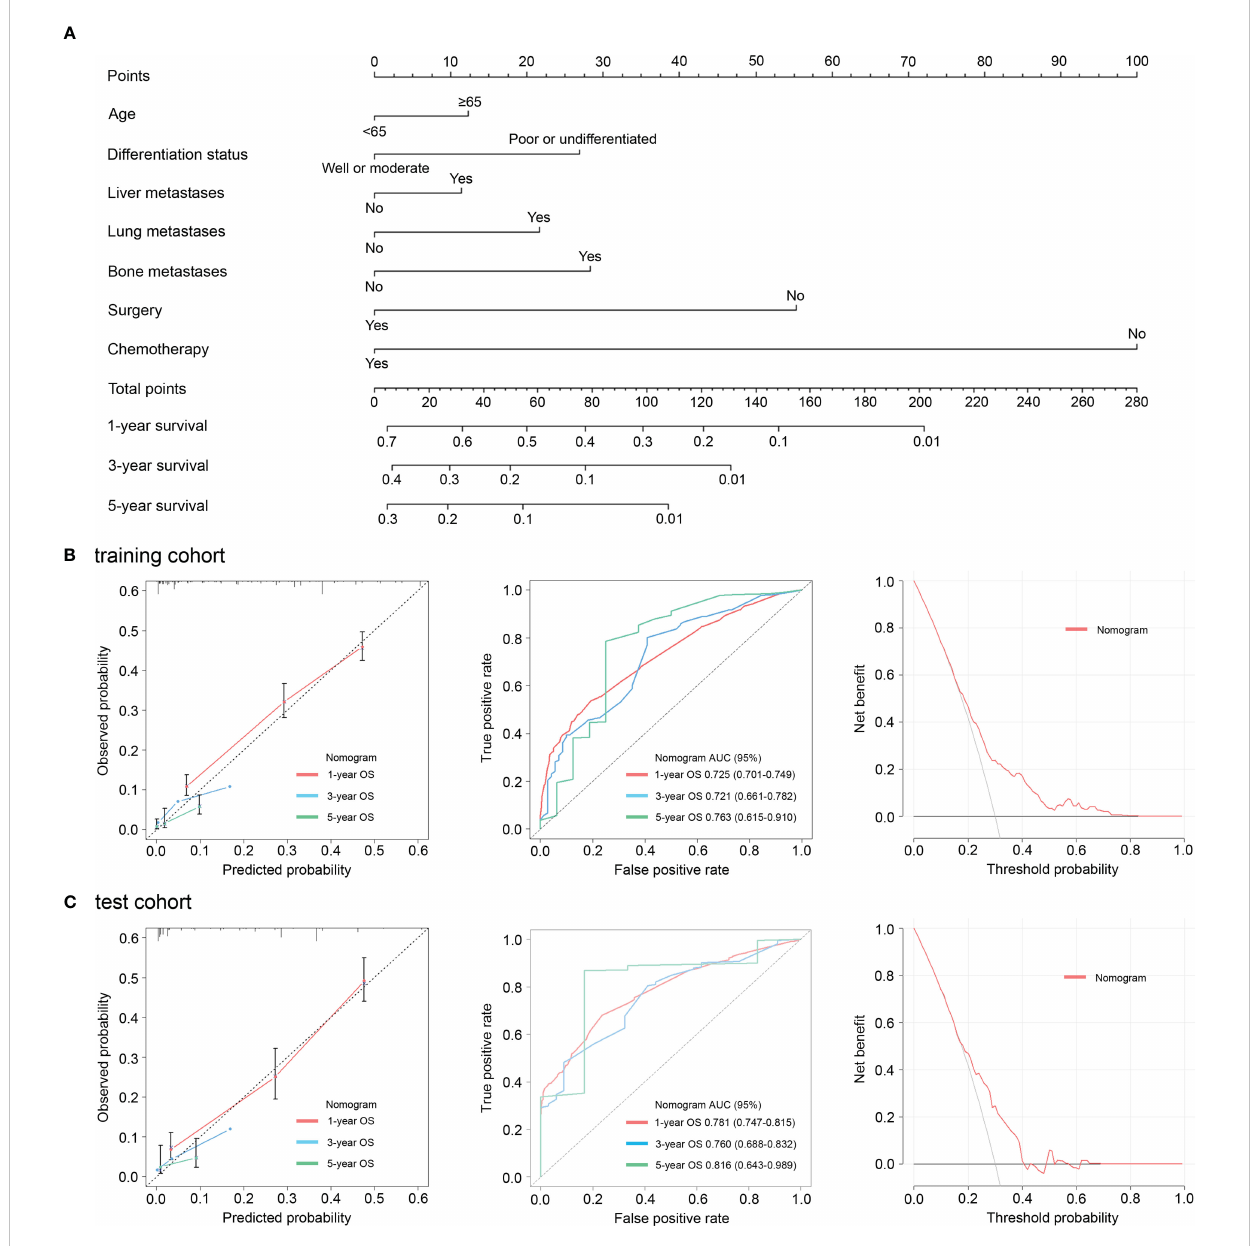
FIGURE 3 Nomograms incorporating the clinic-pathologic characteristics for evaluation of overall survival (A) . Calibration curves, receiver operating characteristic curves, and decision curves revealed good agreements between the predictive and actual probability in the training cohort (B) . Calibration curves, receiver operating characteristic curves, and decision curves revealed good agreements between the predictive and actual probability in the test cohort (C)